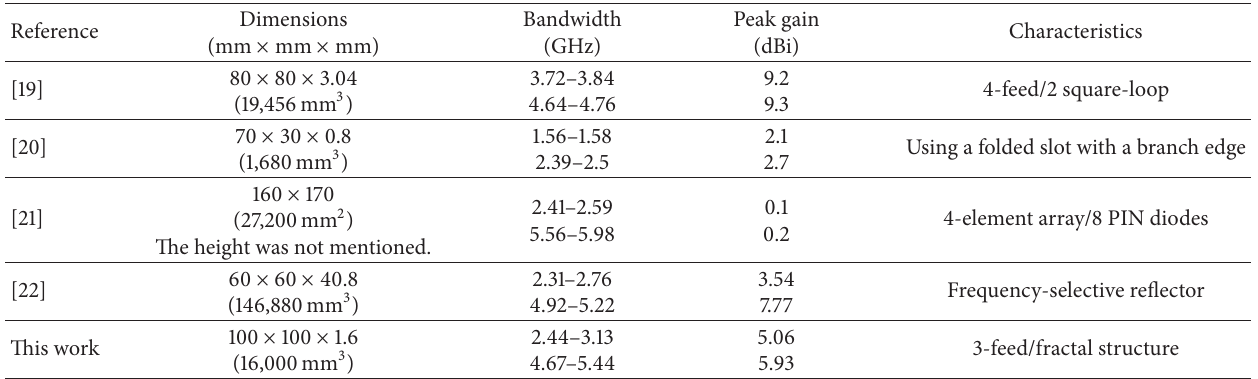
Table 4: Comparison of the proposed antenna with other dual band reconfigurable